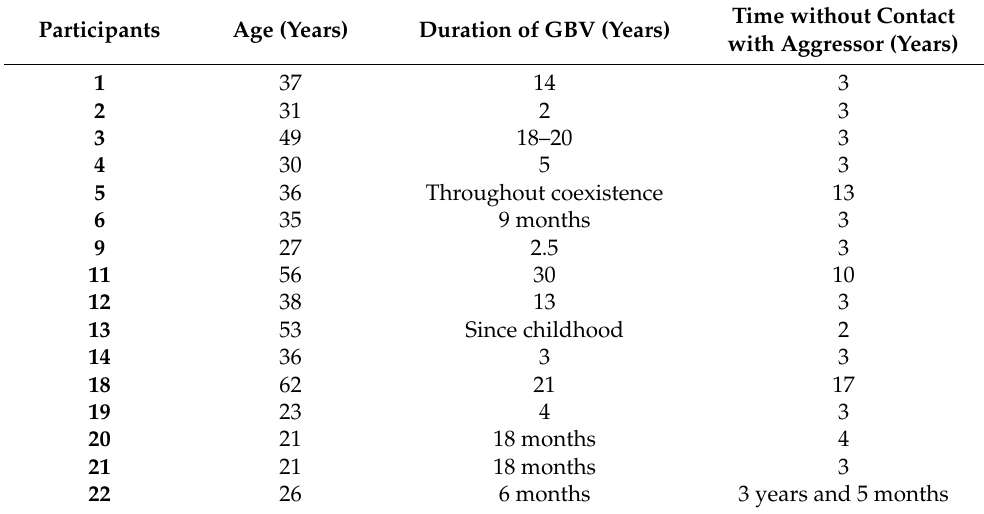
Table 1. Sociodemographic data of the